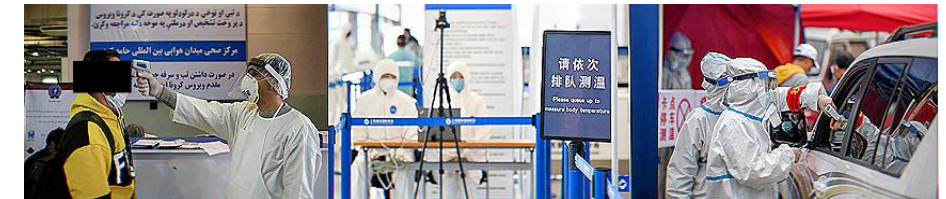
Figure 1. Temperature measurement in public places for COVID-19 regular